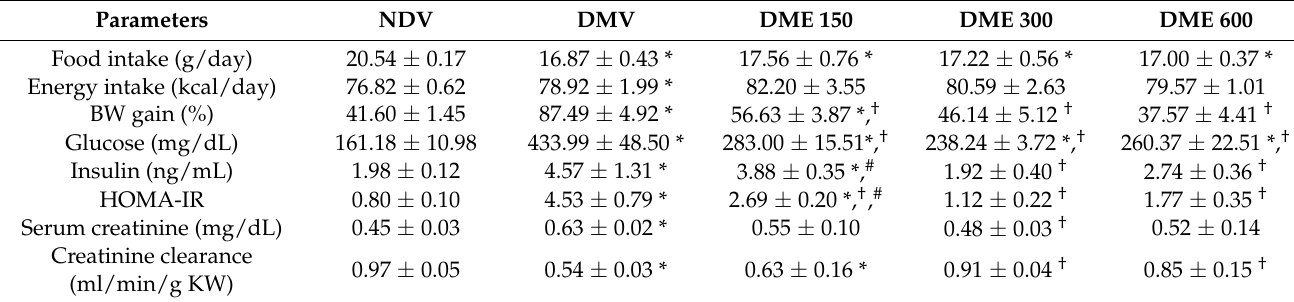
Table A2. Effects of different concentrations of purple rice husk extract (PRHE) on metabolic indexes and renal function (a preliminary